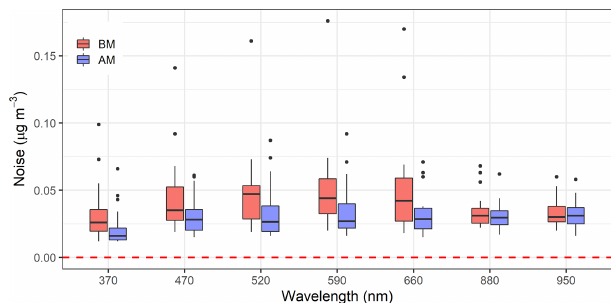
Figure 13. Average instrument noise at the measurement wave- lengths at 1min time resolution. The black horizontal line inside the boxes represents the median noise value; the lower and upper borders of the boxes are the first and third quartiles, on which the middle 50% of the noise values are located; the whiskers corre- spond to ranges for the bottom 25% and the top 25% of the noise without outliers, which are represented by the black points. The red dashed line represents the noise equaling zero. BM: before mainte- nance. AM: after